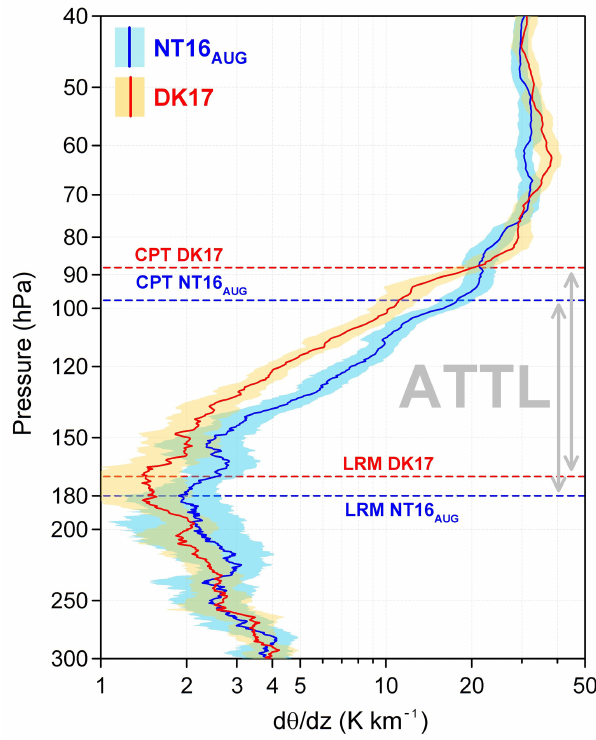
Figure 4. Mean profiles (solid lines) and standard deviations (col- ored shading) of d θ/ d z as a function of pressure for NT16 AUG (blue) and DK17 (red). Horizontal dashed lines show the mean LRM and CPT for NT16 (blue) and DK17 (red). The ATTL re- gions for the two datasets are highlighted by grey arrows. Note that the mean profiles and standard deviations of d θ/ d z were smoothed with a ± 5hPa (about 250m) moving average to reduce the noise contributions from the geometric altitude measurement by